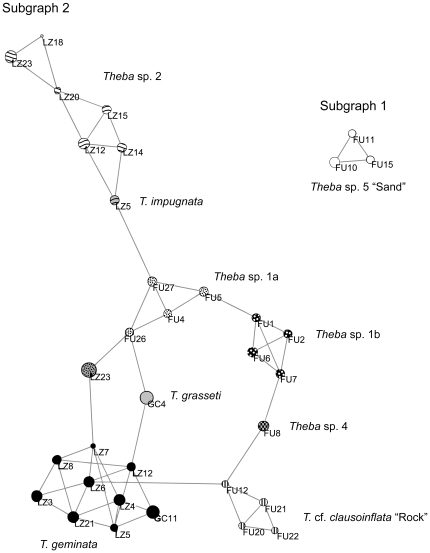
Population graph based on the AFLP data set.The graph represents the genetic covariance relationships among Theba populations of the Canary Islands. Node sizes are proportional to within population genetic variability, whereas the edge lengths represent the among population component of genetic variation.